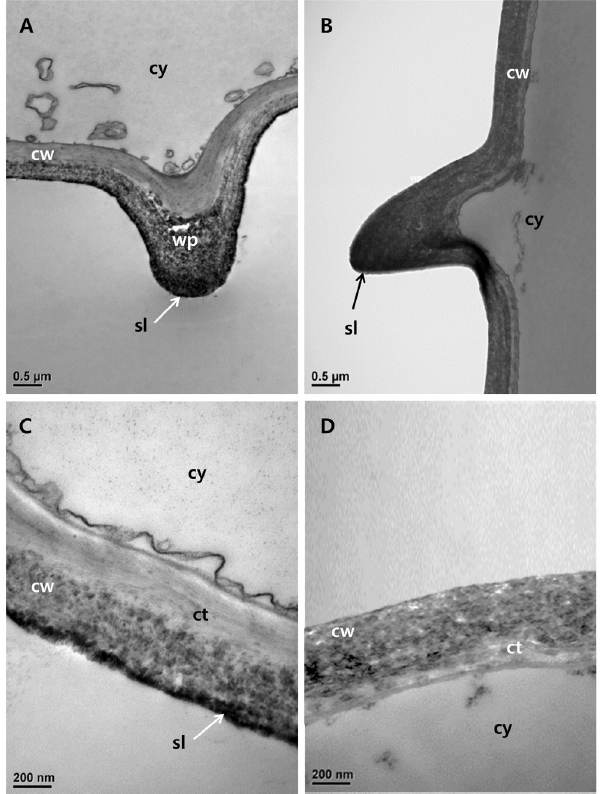
Fig 4. Analysis of leaf structures by transmission electron microscopy (TEM). (A) Epidermal cell wall of the wild- type in the wp region. (B) Epidermal cell wall of the dr mutant in the wp region. (C) Epidermal cell wall of the wild- type without the wp region. (D) Epidermal cell wall of the dr mutant without the wp region. Cy; cytoplasm, cw; cell wall, sl; silicon layer, wp; wart-like protuberances, ct; cuticle layer. Bars = 0.5 μ m.